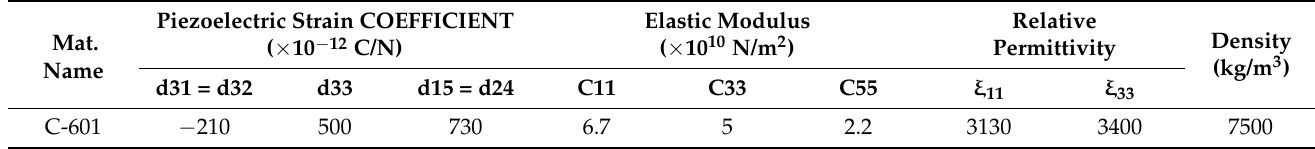
Table 1. Piezoelectric material